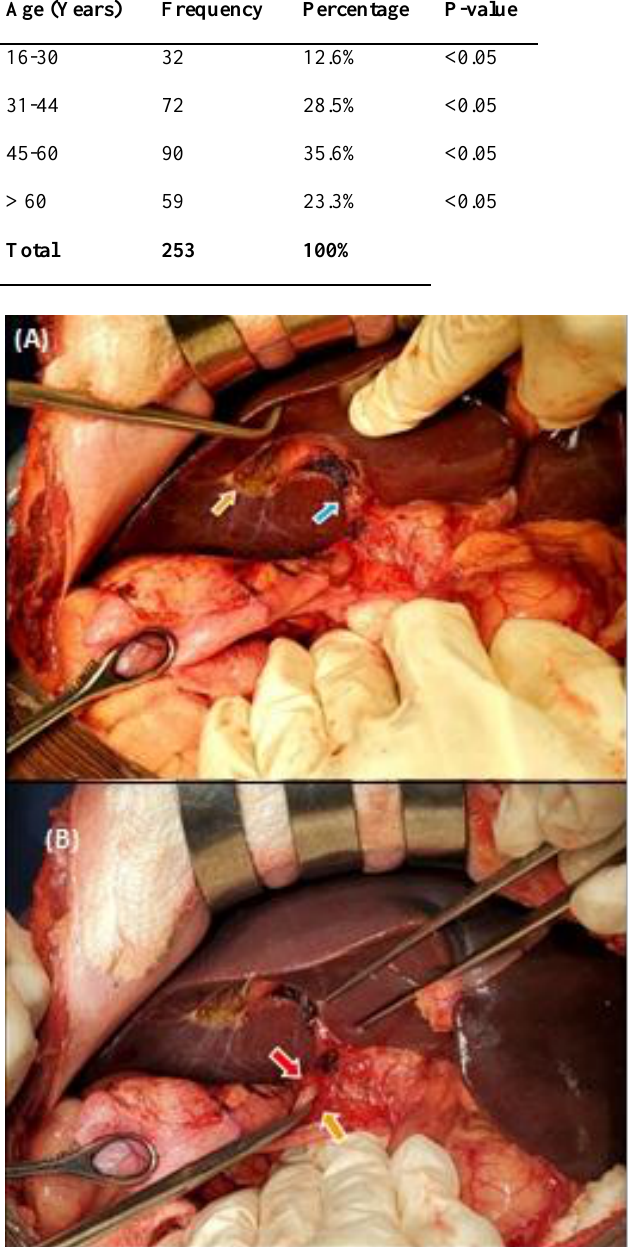
Figure 4: (A) Intra-operative photo of antegrade fundus-first cholecystectomy showed meticulous dissection of the gallbladder from its hepatic bed. (B) Intra-operative photo of open fundus-first cholecystectomy showed hanging of the gallbladder with the support of the cystic artery and cystic